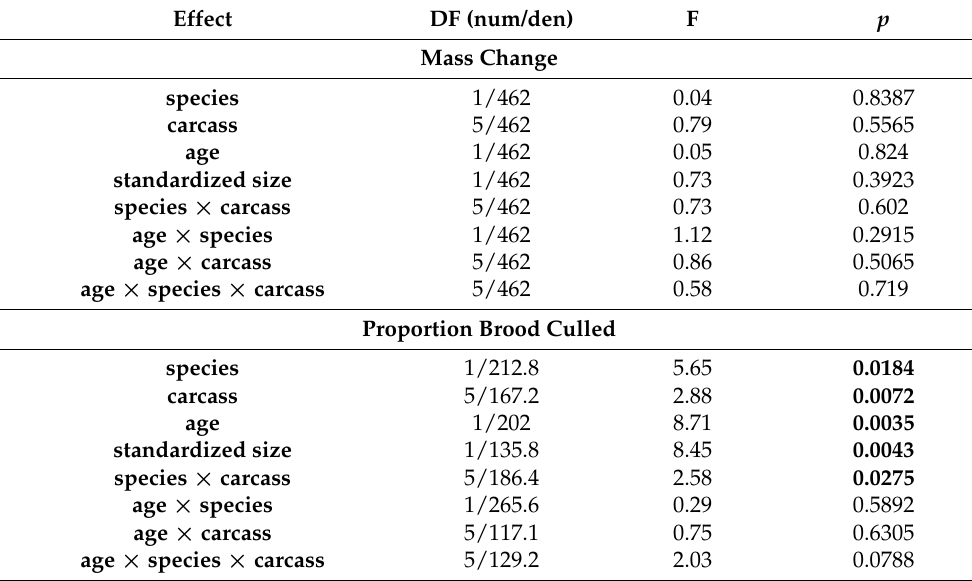
Table 4. Results of repeated measures ANCOVA for mass change, and proportion brood culled. Significant effects are